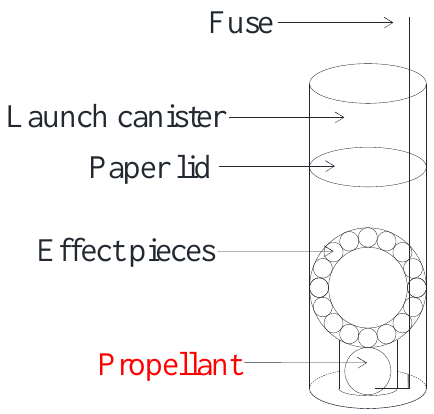
Figure 1. Schematic diagram of fireworks section.